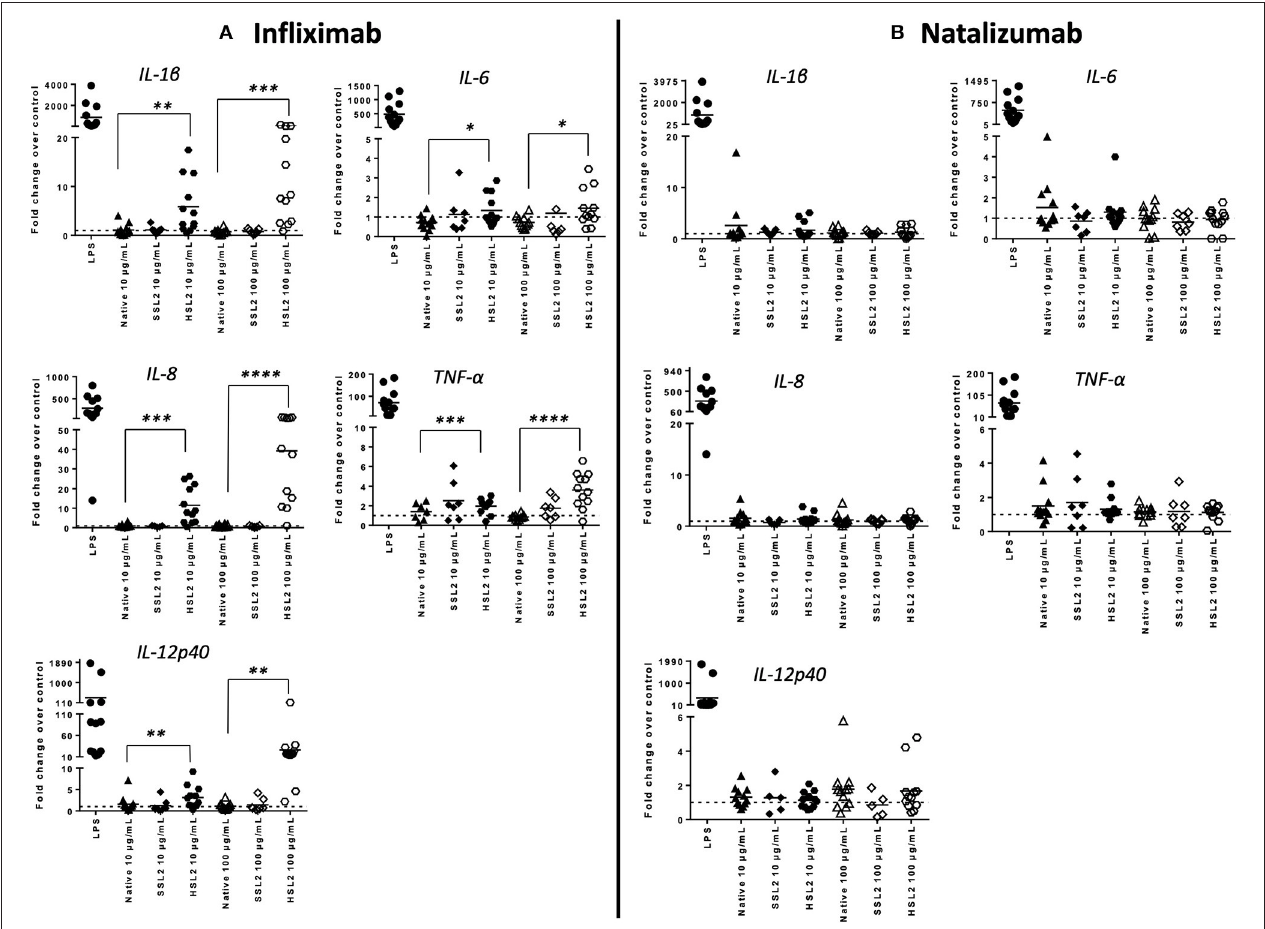
FIGURE 3 | Expression of proinflammatory cytokine mRNA in moDC following treatment with native or aggregated infliximab (A) and natalizumab (B) . Immature moDC were treated with native or stressed (SSL2 or HSL2) antibodies. Transcripts were measured after 6h (for IL-1 β , IL-6, IL-8, and TNF α ) or 24h (for IL-12p40) using real-time RT-PCR. Results are expressed as fold change over PBS control. The results from 12 independent experiments are shown. * p < 0.05; ** p < 0.01; *** p < 0.001; **** p <